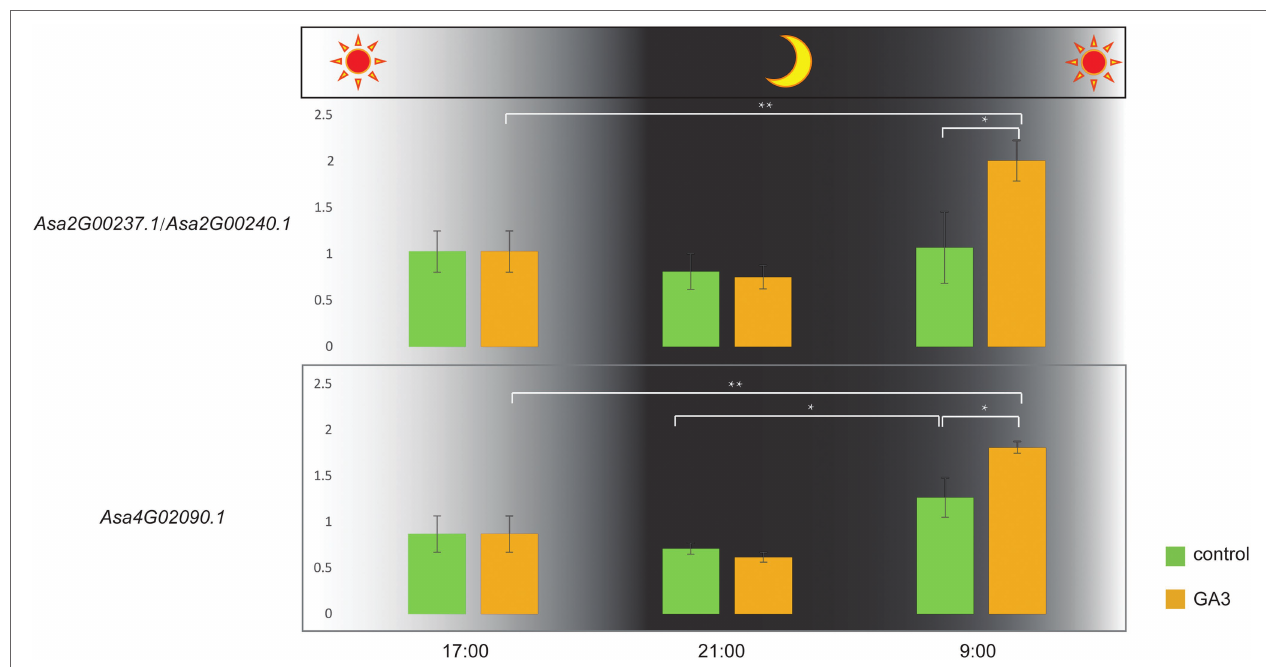
FIGURE 6 | Expression differences of DELLA subfamily genes in one-month-old garlic seedlings sprayed with GA3 solution (sampling times: 0, 4, and 16 h after treatment). * and ** indicate significant differences at the 0.05 and 0.01 levels, respectively. Control: the same amount of distilled water treatment, GA3: 200 mg/l GA3